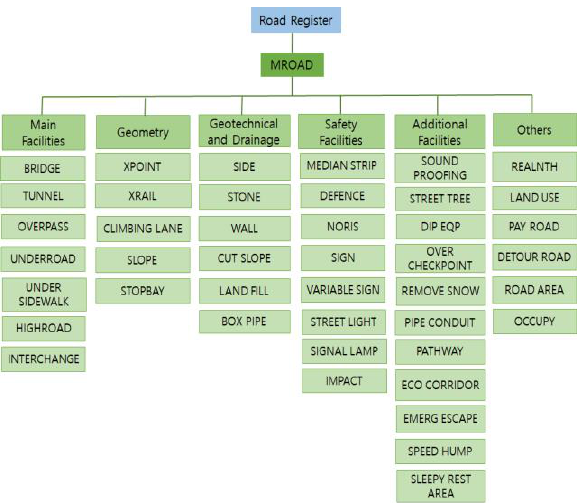
Figure 1. Types of the road register (MOLIT, 2015,